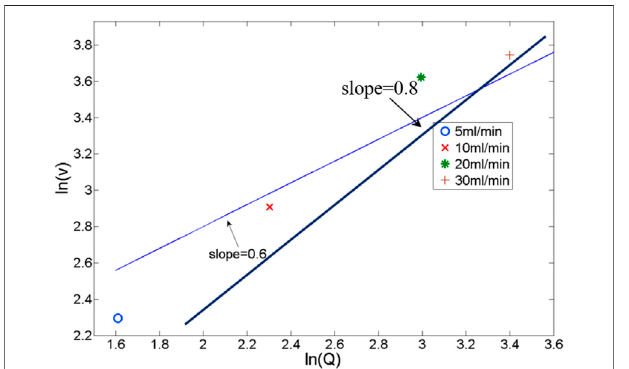
FIGURE10| Averagedpore watervelocity overthecross-sectionalarea outside the bubble plume.